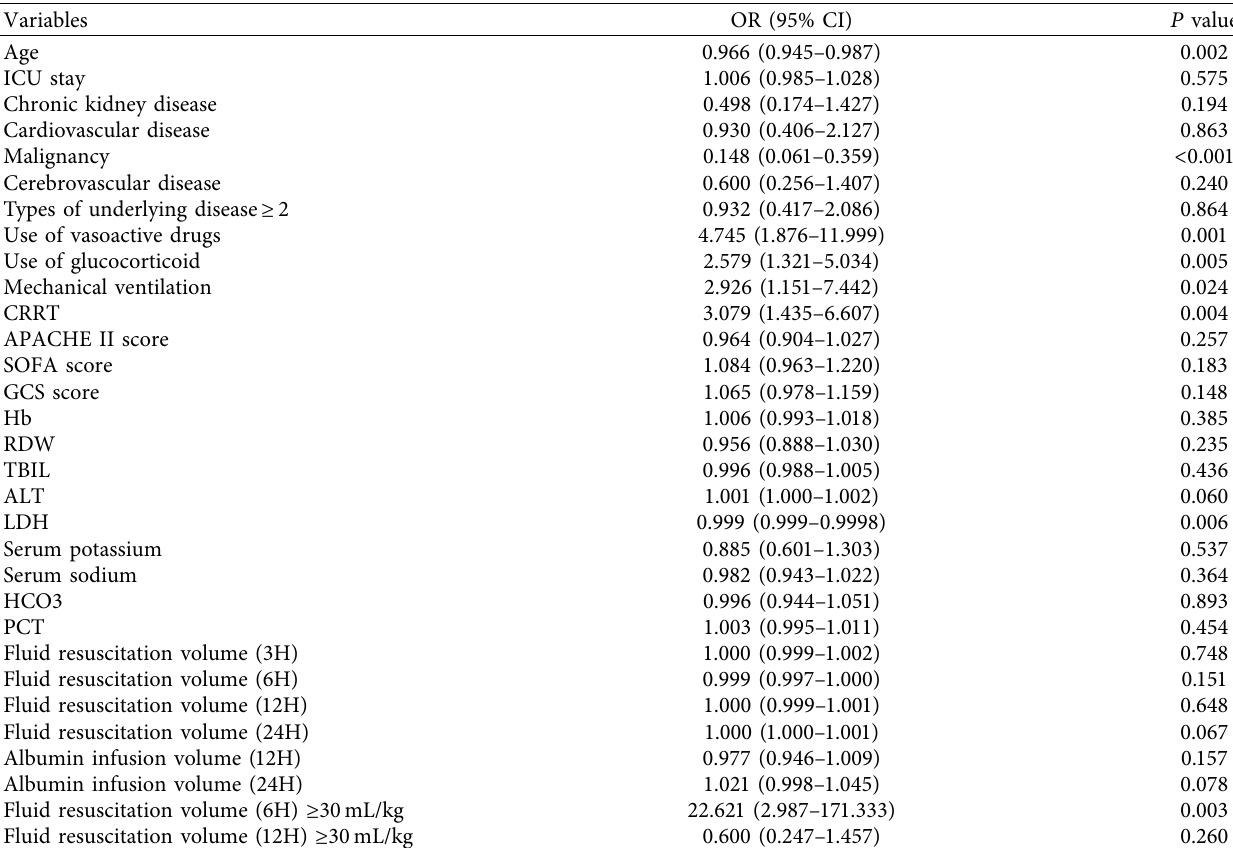
Table 6: Multivariate analysis of predictive factors for hospital mortality of patients in the low lactate group.